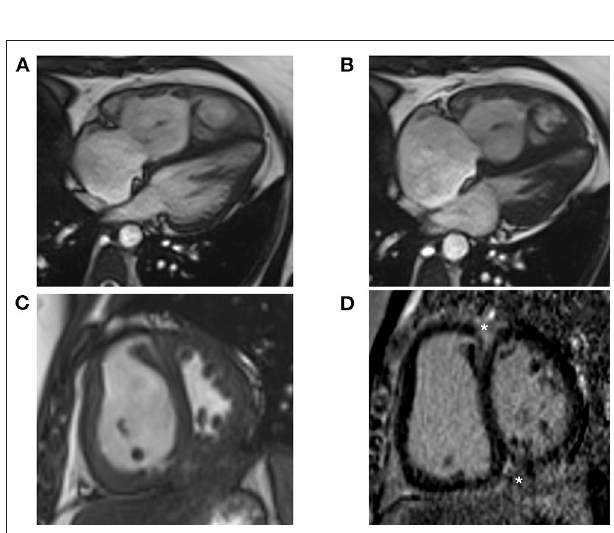
FIGURE 5 | Cardiac Magnetic Resonance (CMR) images are shown from a 38-year-old female with idiopathic pulmonary arterial hypertension. (A) Four-chamber bright blood CMR image from end diastole shows a dilated and hypertrophied right ventricle at a mean pulmonary pressure of 47 mmHg. End systolic images show leftward bowing of the interventricular septum from elevated right ventricular pressure. (B) Late systolic images show leftward bowing of the interventricular septum from elevated RV pressure. (C) Short axis CMR image shows marked hypertrophy of the right ventricular free wall and septal bowing. (D) Short axis LGE image shows prominent enhancement at the anterior and inferior RV insertion points (asterisks).